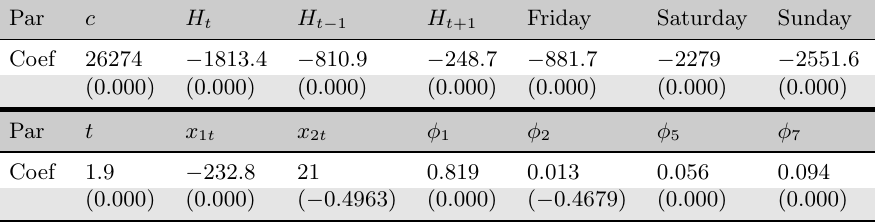
Table 1: Parameter estimates for the piecewise linear regression